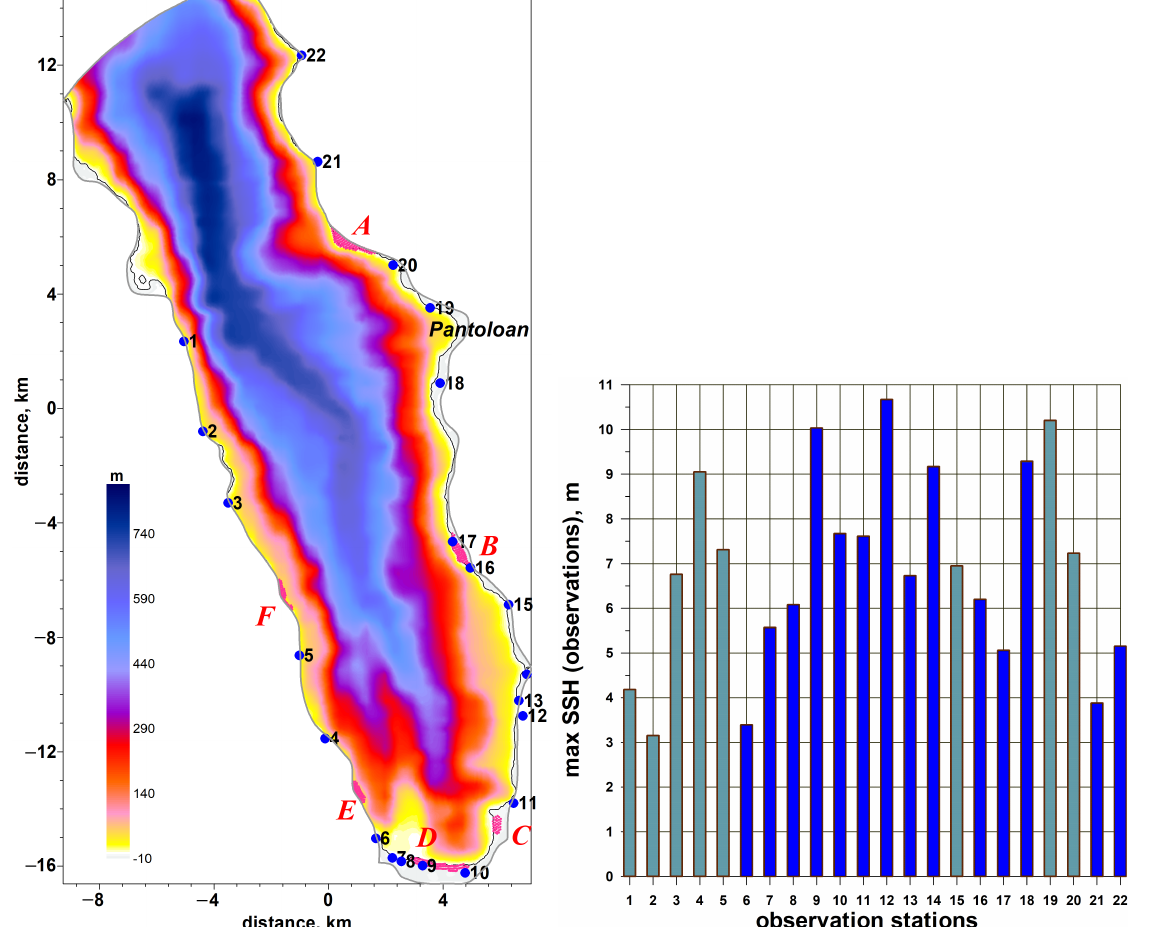
Figure 2. Left panel: Model domain, bathymetry, observational locations (1–22), landslide positions ( A − F ). Grey line—topography 10 m; black solid line—0 m depth; right panel: observed sea level height for locations 1–22 [46]. Dark blue bars show observation stations located in the coastal zone of the modelling